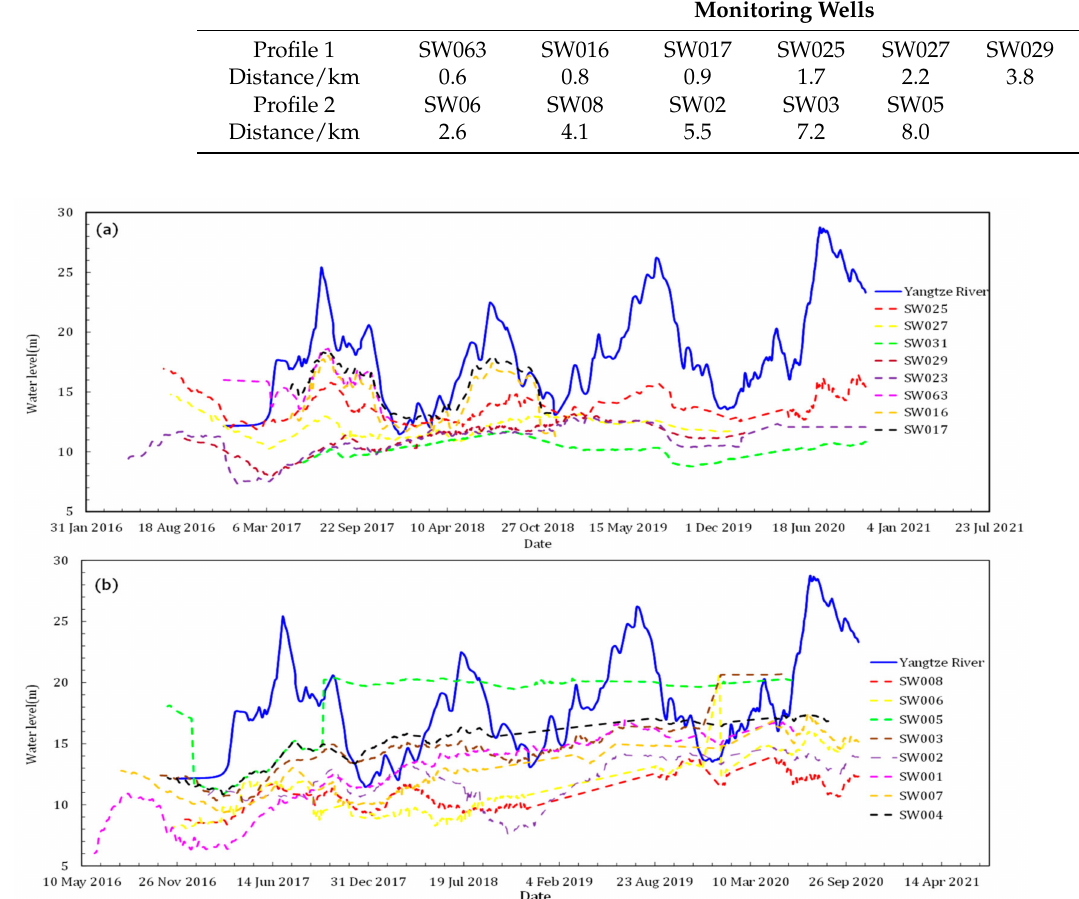
Figure 4. Diagram of the Profile 1 ( a ) and Profile 2 ( b ) river level and confined water level